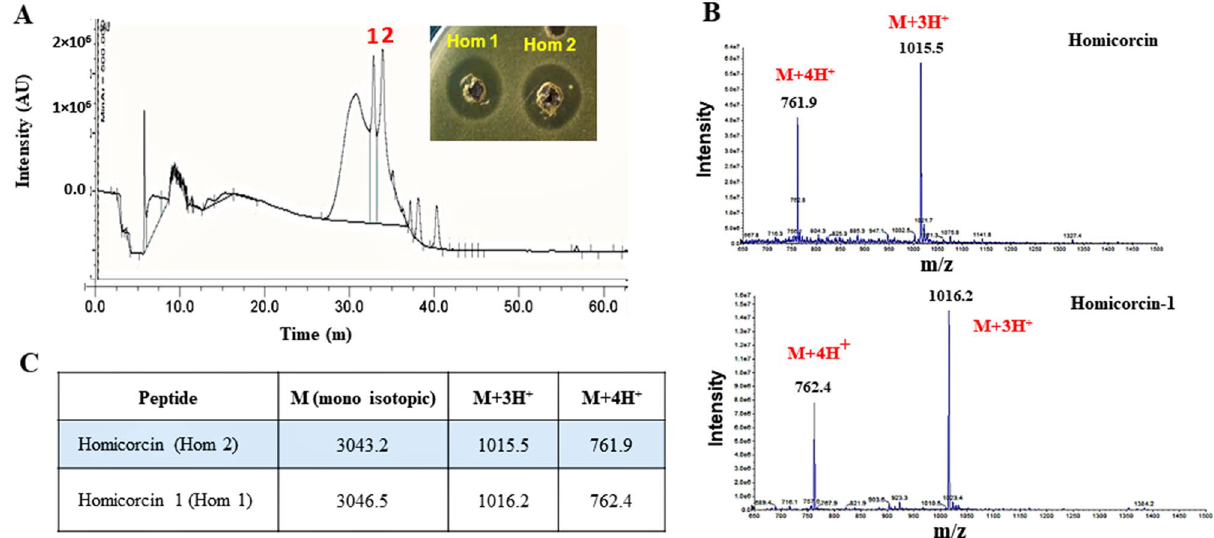
Figure 2. Purification of homicorcin through RP-HPLC and mass determination of active peaks by LC–MS. ( A ) RP-HPLC of active fractions (pooled from ion exchange); Two bioactive (peak-1 and peak-2) fractions were found eluting at 40% and 42% ACN gradient respectively . ( B ) Strong single peak found in each mass/charge (m/z) state. ( C ) Mass differences observed between homicorcin and its variant homicorcin 1.